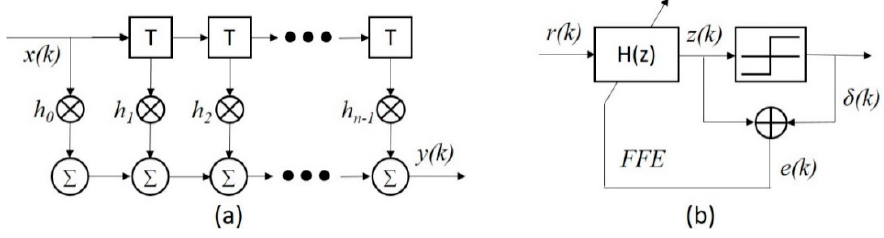
Figure 7. The structure of ( a ) FIR filter: H(z); ( b ) FFE.